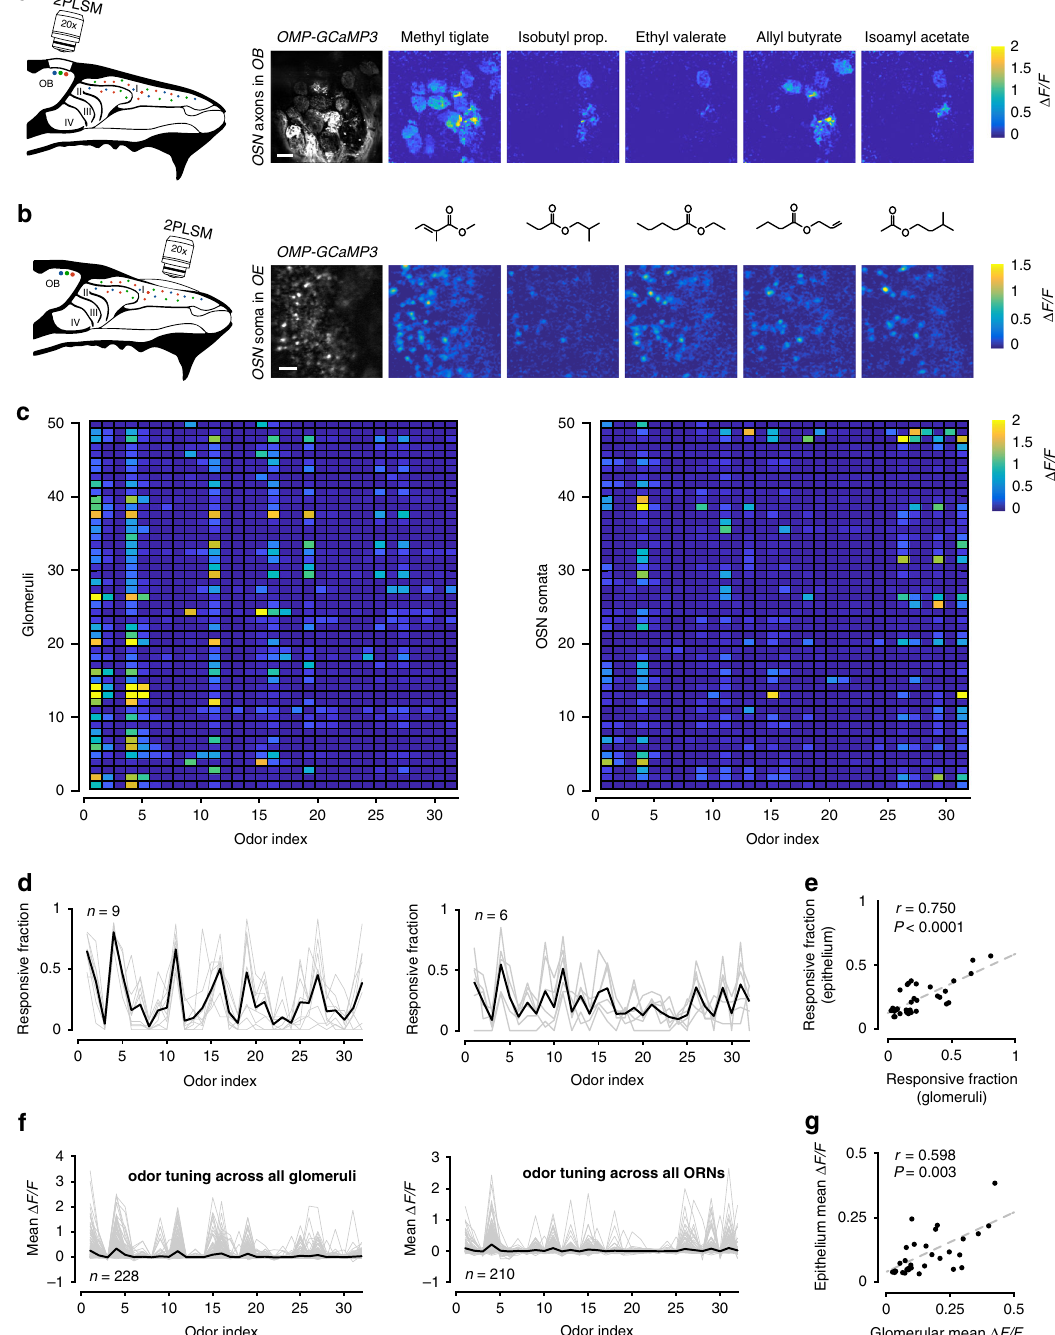
Fig. 5 Odor tuning in the dorsal recess of the olfactory epithelium is similar to the dorsal olfactory bulb. a Left, experimental setup for imaging axon terminals of OSNs in the glomerular layer of the olfactory bulb from one of fi ve mice used. Right, resting fl uorescence of glomeruli and heatmaps of selected odor responses. Scale bar is 100 µ m. b Left, experimental setup for imaging OSN somata in the olfactory epithelium from one of six mice. Right, resting fl uorescence in the soma of GCaMP3 -expressing OSNs in the olfactory epithelium and heatmaps of selected odor responses. Scale bar is 30 µ m. c Odor tuning of 50 randomly selected glomeruli (left) and 50 OSN (right) across 32 monomolecular odors. Odor index is consistent for each panel and follows Table 3. d Fraction of glomeruli (left; n = 9 imaging fi elds) or somata (right; n = 6 imaging fi elds) that responded to each of the odors in a given imaging fi eld. Grey lines are individual fi elds and dark line is the mean across all imaging fi elds. e Scatter plot of the responsive fraction across all glomeruli and somata for each of the 32 odors used. Dashed line is the linear regression to the data (Pearson ’ s correlation coef fi cient r = 0.750, P < 0.0001). f Odor tuning of 228 glomeruli (left) and 210 OSN somata (right). Grey lines are individual glomeruli or somata and dark line is the mean across all ROIs. g Scatter plot of the mean response across all glomeruli and somata for each of the 32 odors used. Dashed line is the linear regression to the data (Pearson ’ s correlation coef fi cient r = 0.598, P =